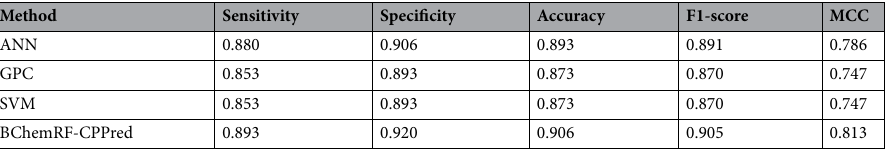
Table 1. Comparison of accuracy, sensitivity, specificity, F1-score, and MCC obtained for ANN, GPC, SVM, and BChemRF-CPPred in the independent test using FC-4.